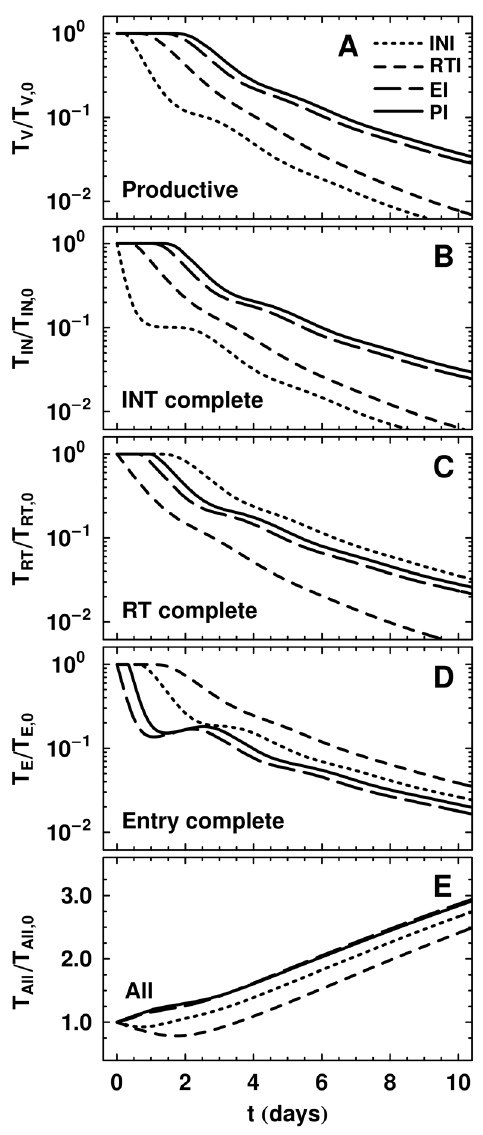
Figure 4. Companion CD4 + T cell dynamics to Figure 3 for the optimal model. Here monotherapy is administered for the four different drug classes. All T cell species have been normalized to t ~ 0 and are denoted generically by T = T 0 . (A) Productive CD4 + T cells. (B) CD4 + T cells with integration complete. (C) CD4 + T cells with reserve transcription complete. (D) CD4 + T cells with entry complete. (E) All CD4 + T cells irrespective of their infection stage, including uninfected CD4 + T cells. Comparison of (A) to Figure 3 shows viral load tracks the number of CD4 + T cells producing virus T V regardless of drug class, with the remaining infected CD4 + T cell species dynamics depending on the stage of inhibition. The final panel (E) shows the sum of all CD4 + T cells in the model T All ~ T z T E z T RT z T IN z T V . Note that thetargetplus infected CD4 + T cells T All increase quasi-linearly as anticipated after the removal of the majority of infection with ART. Efficacy is